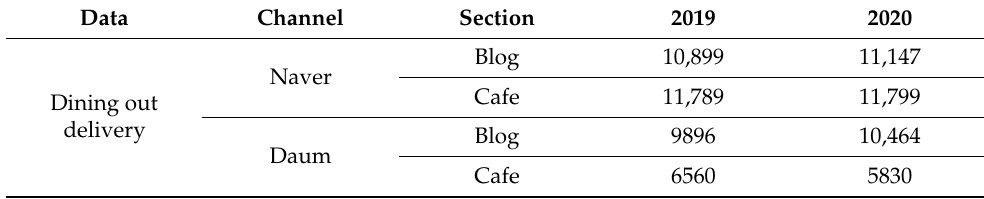
Table 1. Survey of collected data.